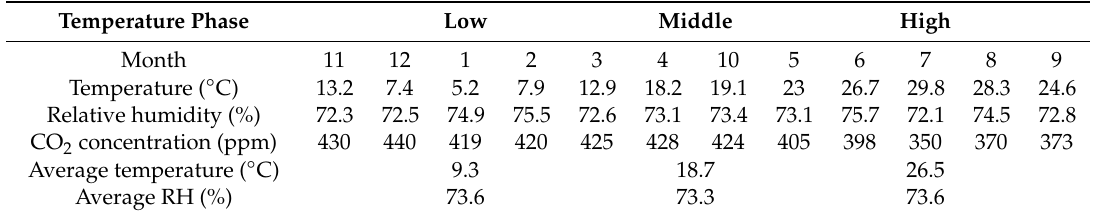
Table 3. Statistical environmental information based on the city meteorological data during a calendar year.